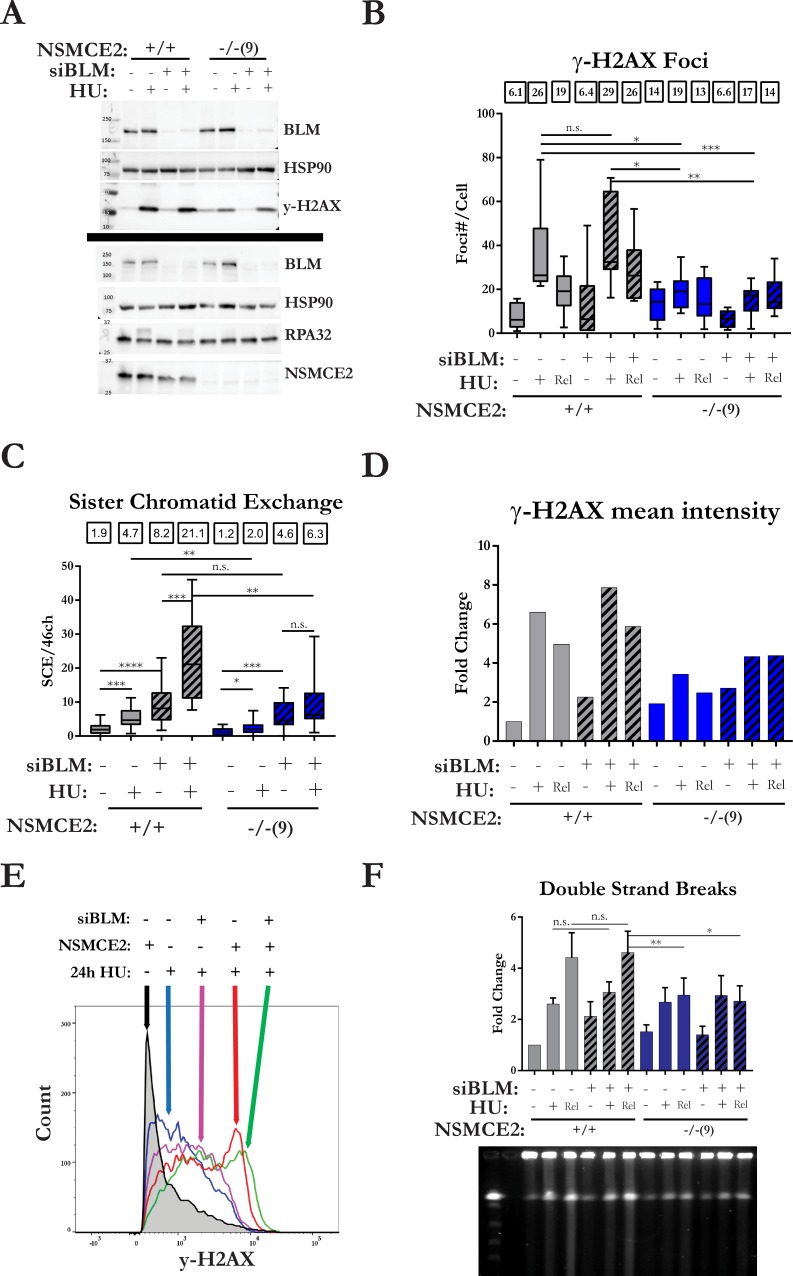
NSMCE2 is epistatic to BLM for HU-induced phenotypes.Analysis of HU-induced phenotypes in normal HEK293T and NSMCE2 null cells in which BLM levels were reduced or not by siRNA-mediated depletion. (A) Western blot analysis of levels of phosphorylation of H2AX and RPA. Black line indicates separate blots using lysates from the same experiment. The experiment was performed two times. (B) Analysis of focal concentrations of γ-H2AX after treatment with HU for 24 hours and after release into normal medium for 6 hours. Box and whisker plots representing at least 10,000 γH2AX foci in two independent experiments. Medians are shown above the graph. (C) Levels of HU-induced SCEs. Box and whisker plots representing distribution of SCE per metaphase. Medians of the combined data are shown above the graph. Two independent experiments were performed. Unpaired t-test was performed to analyze the distributions. (D) Analysis by flow cytometry of fluorescence intensity of γ-H2AX after treatment with HU for 24 hours and after release into normal medium for 6 hours. Median florescence intensity was measured from a minimum of 10,000 events. The bar graph represents the fold change in median fluorescent intensity normalized to untreated normal HEK293T cells exposed to control siRNA from a single experiment. Two independent experiments were performed. (E) Representative distributions of fluorescence intensity of cells in selected conditions from the flow cytometry data. (F) Analysis by PFGE of DSBs after treatment with HU for 24 hours and after release into medium for 6 hours. The bar graph represents fold change in DSBs detected by PFGE normalized to untreated normal NSMCE2 cells exposed to control siRNA. The error bars represent the SEM of three independent experiments. The gel below the bar graph contains the results from one experiment. See Fig 1 for definition of asterisks.